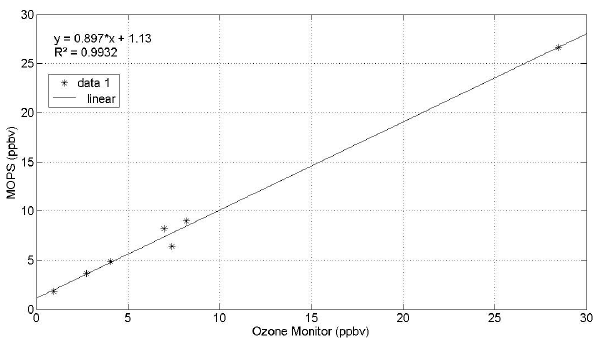
Fig. 3. Ozone differences seen by MOPS as a function of differ- ences seen by a Thermo Scientific 49i ozone